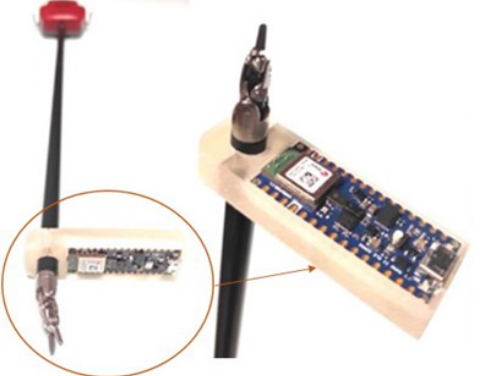
Figure 6. Complete prototype of the second version of the detection device connected to the En- doWrist tool of dVRK